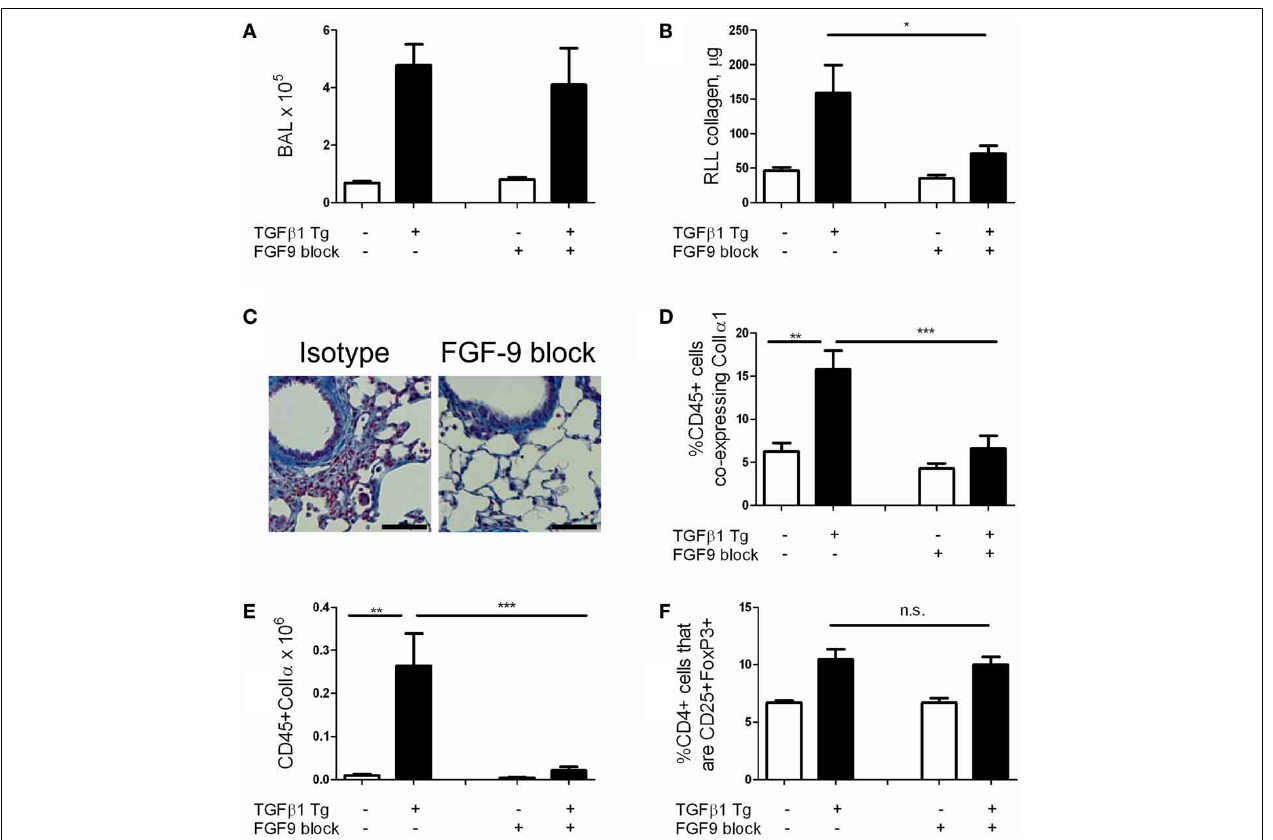
FIGURE 6 | FGF-9 blockade reduces lung fibrocyte accumulation and fibrosis in TGF- β 1 transgenic mice. TGF- β 1 Tg + and Tg − mice were administered 14 days of doxycycline and injected i.p. with either FGF-9 neutralizing antibody or isotype control on days—1, 2, 5, 8, and 11. (A) BAL leukocyte concentration (absolute # per μ l). (B) Lung collagen content as measured by Sircol assay performed on the right lower lobe (RLL). (C) Trichrome staining of paraffin